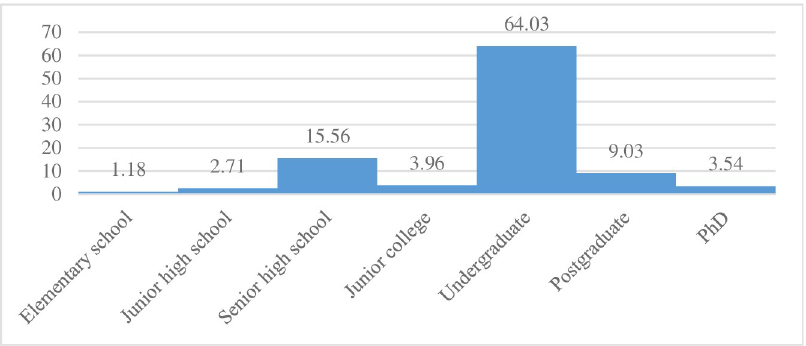
Fig 1. Distribution of percentage of expected educational level of sending children to study abroad (%).